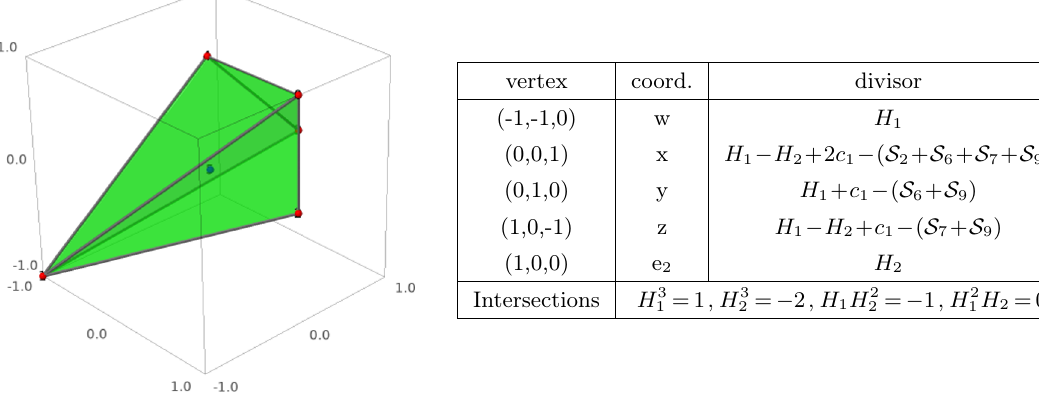
Figure 3 . The ambient space polytope of nef (6,1). The table shows the respective coordinates and the bundles they transform